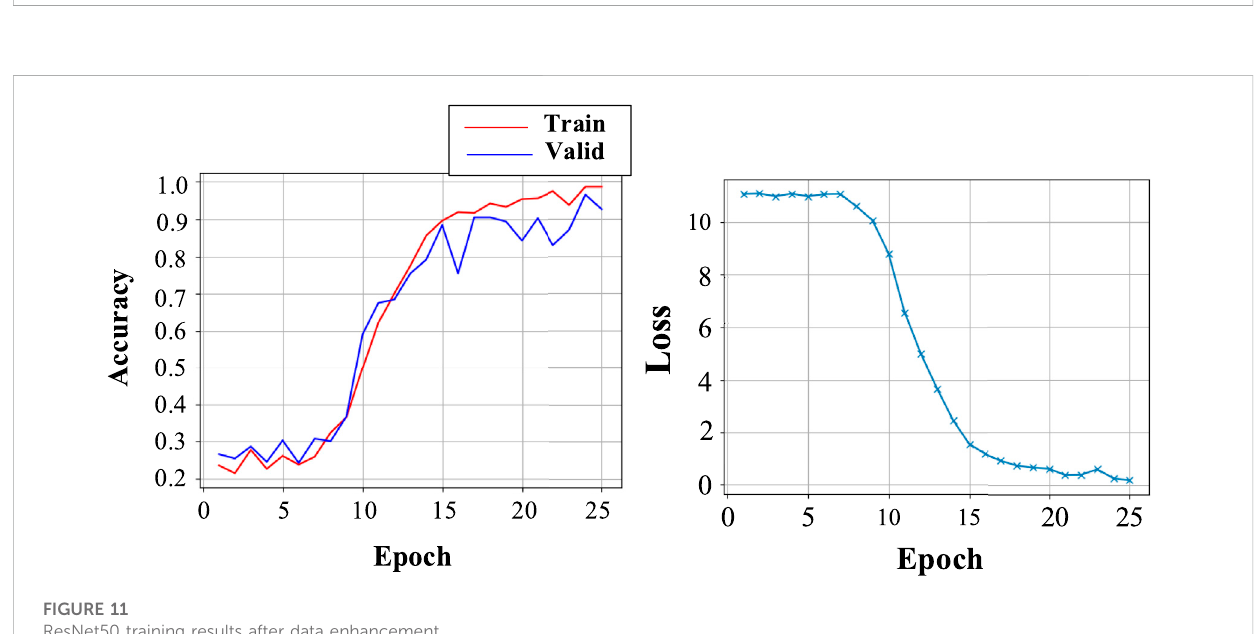
FIGURE 11 ResNet50 training results after data